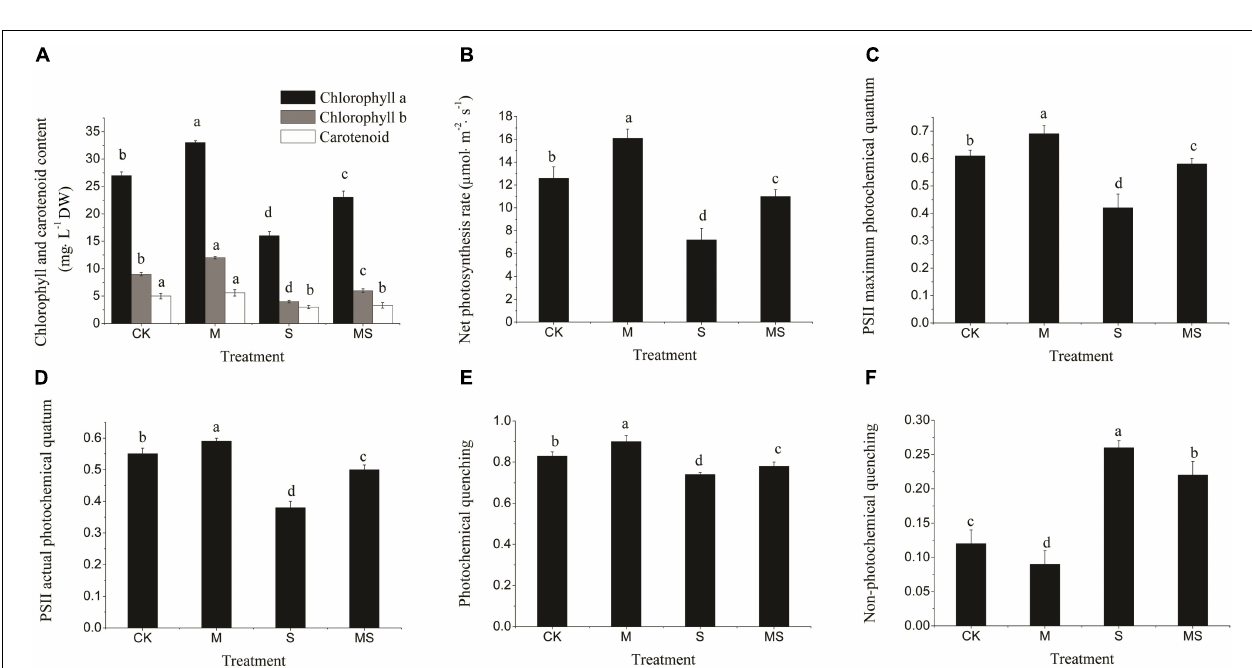
FIGURE 4 | Chlorophyll content, photosynthesis rate, and PSII electron transport in watermelon inoculated or non-inoculated seedlings with AMF Funneliformis mosseae and subjected or not to salinity-alkalinity stress. (A) Chlorophyll a, chlorophyll b, and carotenoid content. (B) Net photosynthesis rate. (C) PSII maximum photochemical quantum. (D) PSII actual photochemical quantum. (E) Photochemical quenching. (F) Non-photochemical quenching. PSII, photosynthesis system II; AMF, arbuscular mycorrhizal fungi; CK, without AM inoculation + without salinity-alkalinity; M, with AM inoculation + without salinity-alkalinity; S, without AM inoculation + with salinity-alkalinity; and MS, with AM inoculation + with salinity-alkalinity. Values are means ± standard errors ( n = 10). Bars with different letters are significantly different at the 0.05 level (Duncan’s multiple range test).